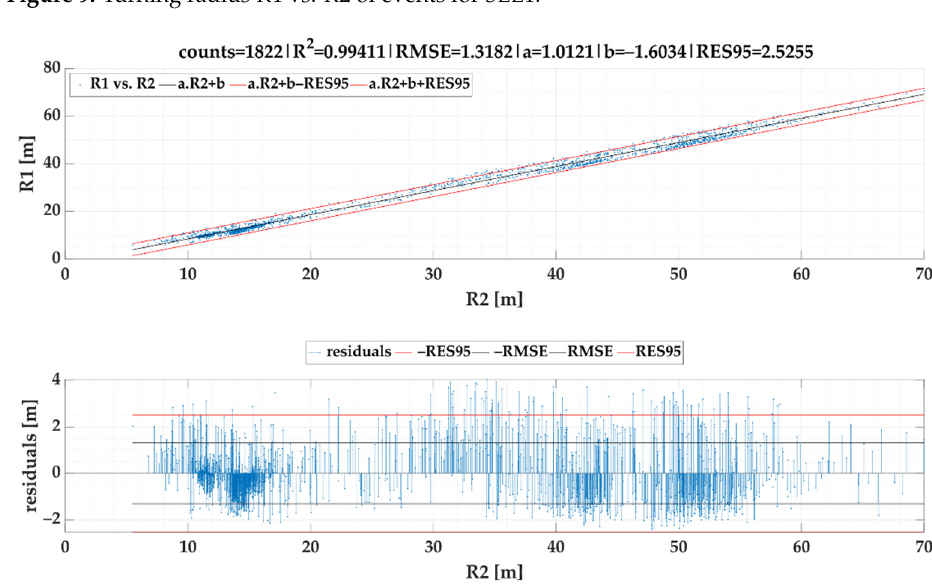
Figure 10. Turning radius 𝑅1 vs. 𝑅2 of events for